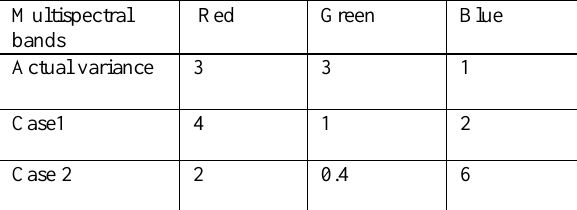
Figure 5a. Projected 16 ×16 pixels for red channel